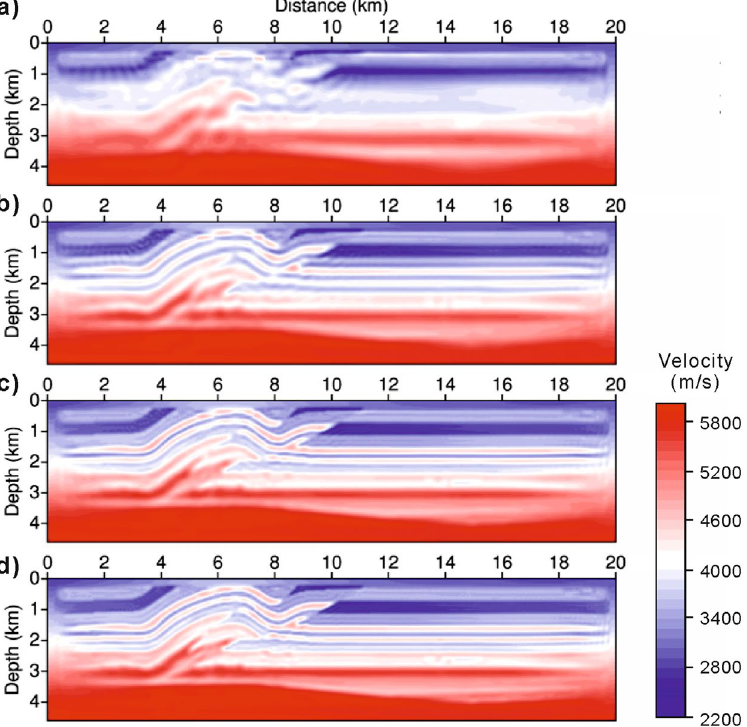
Figure 4. Velocity models reconstructed by FWI without shot-encoding. (a,b,c,d) Results corresponding to the respective data sets of four frequency bands. These results are the benchmarks used for the shot-encoded FWI with the restarted L-BFGS algorithm proposed in this paper.